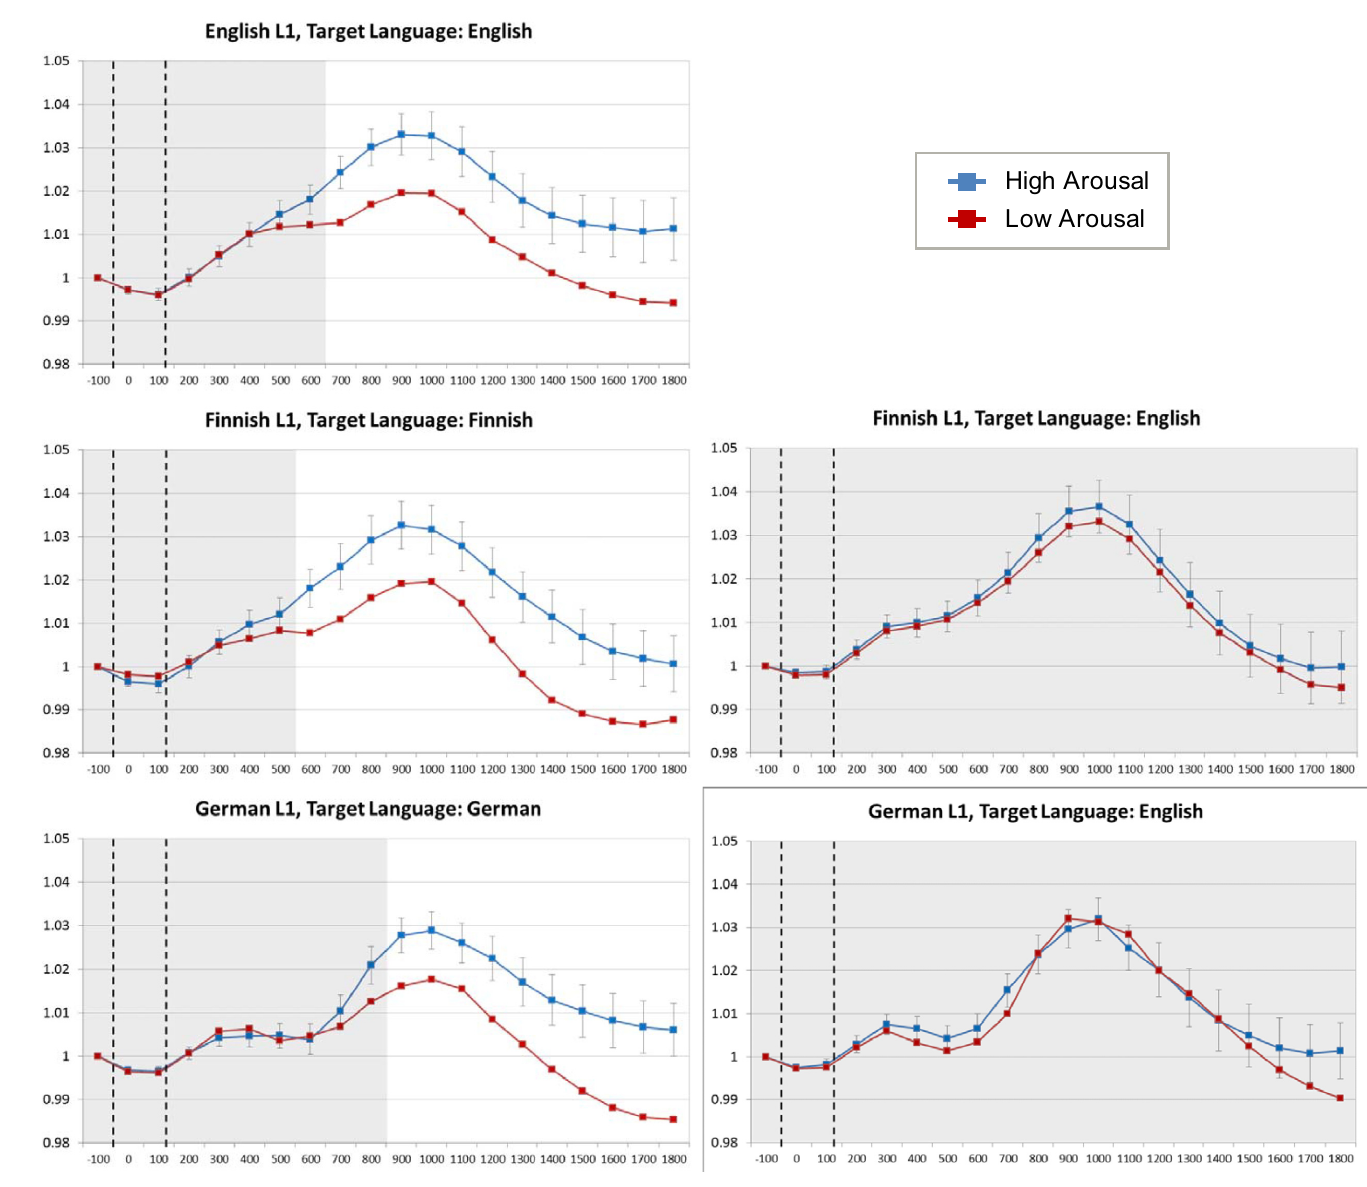
Fig 3. Covariate-adjusted estimated marginal means for proportional pupil size changes over time. Time is partitioned into 100-ms time bins (X-axis labels refer to the temporal onset of each time bin relative to stimulus onset). Vertical dashed lines indicate the average onset and offset of the presented word. Blue curves: High Arousal words; red curves: Low Arousal words; Top to bottom: English, Finnish, and German L1 participants; Left hand panels: stimuli presented in participants’ first language; Right hand panels: stimuli presented in participants’ second language. Error bars refer to standard errors for the simple effect of Word Type derived from linear mixed effect model analyses (see text). White areas indicate time bins where the simple effect of Word Type was significant at p < .05.